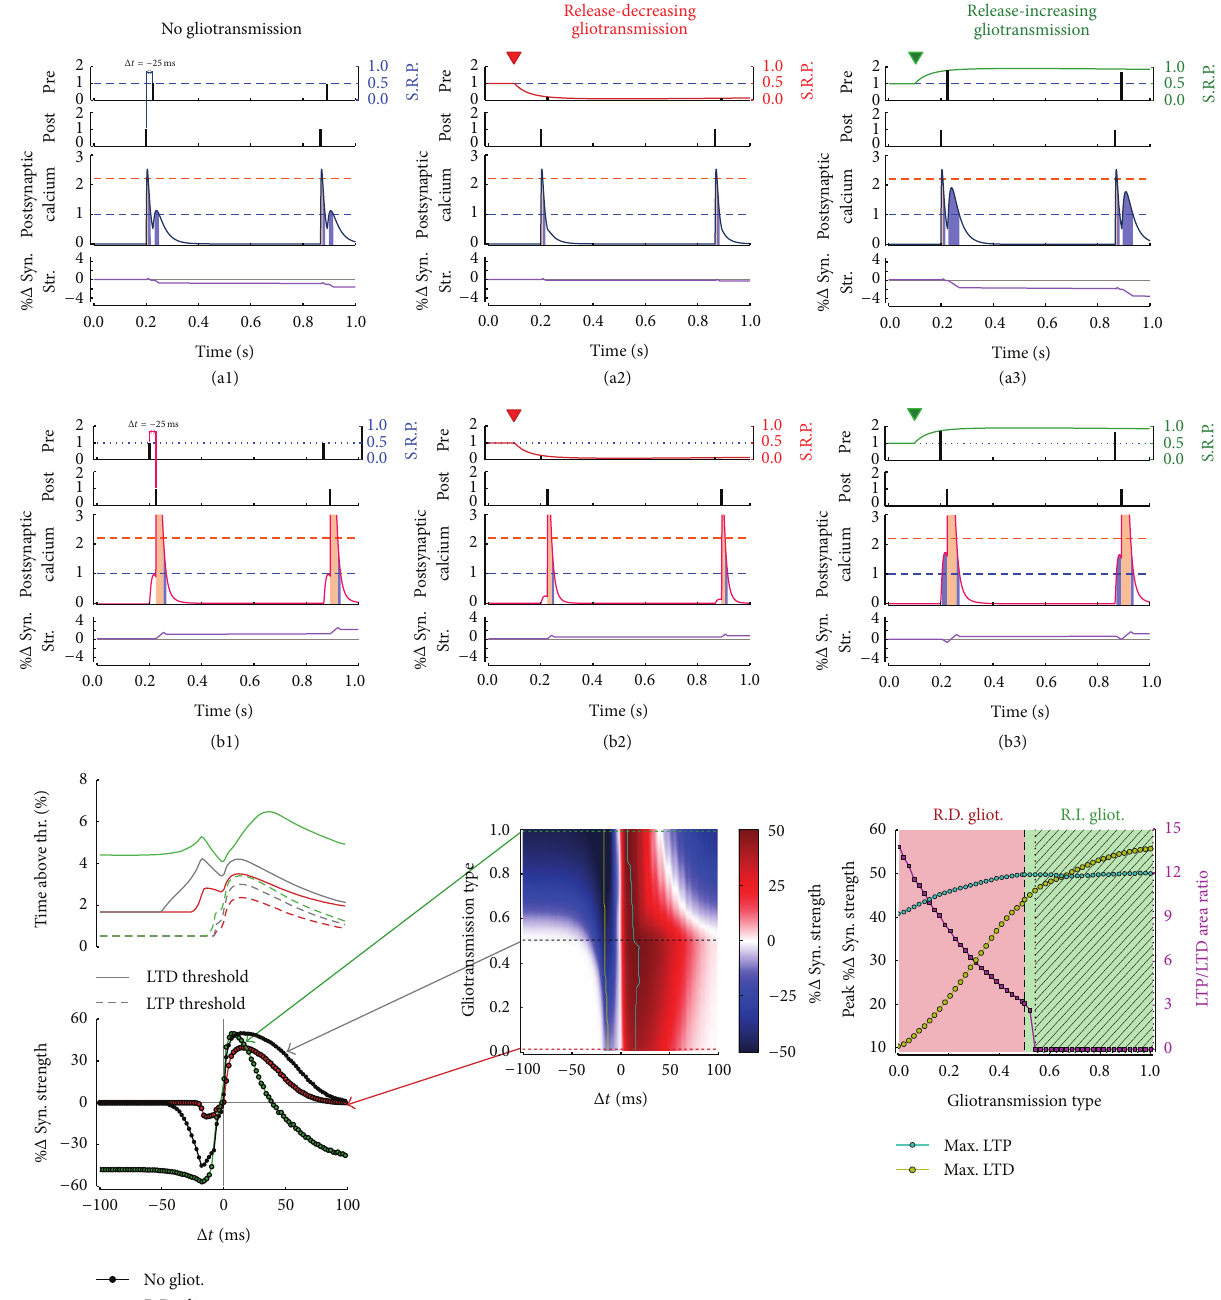
Figure 6: STDP modulation by gliotransmitter regulation of synaptic release. ((a), (b)) Rationale of LTD and LTP without ((a1), (b1)) and with either release-decreasing ((a2), (b2), 𝜉 = 0 ) or release-increasing gliotransmission ((a3), (b3), 𝜉 = 1 ) setting on at the red / green marks . (c) Percentage of time spent by postsynaptic Ca 2+ transients ( left panel ) above depression ( dashed lines ) and potentiation thresholds ( solid lines ) for spike-timing intervals ( Δ𝑡 ) within ± 100ms and resulting STDP curves ( right panel ) in the absence of gliotransmission (no gliot., black curve ) and with maximal release-decreasing (RD, red curve ) or release-increasing gliotransmission (RI, green circles ). (d) In general, strength and direction (i.e., “type”) of gliotransmission may dramatically modulate STDP. For example, synaptic changes are attenuated when synaptic release is decreased by gliotransmission (area below the black dashed line ). Conversely, for sufficiently strong release-increasing gliotransmission (area above the black dotted line ), the LTP window shrinks and LTD may be measured for all Δ𝑡 < 0 , as well as for sufficiently large Δ𝑡 > 0 . (e) A closer inspection of STDP curves indeed reveals that LTD ( yellow curve ) increases for larger synaptic release accounted by gliotransmission, while the ratio between areas underneath the LTP and LTD ( magenta curve ), initially in favor of the former (i.e., for release-decreasing gliotransmission), reduces to zero for large enough release-increasing gliotransmission, when two open LTD windows appear outside a small LTP window center for small Δ𝑡 > 0 ( hatched area ). Synaptic parameters: 𝜏 𝑑 = 0.33 s, 𝜏 𝑓 = 0.33 s, and 𝑈 = 0.5 s. Other parameters as in Table 1 except for 󰜚 𝑒 = 10 −4 , 𝜏 𝑐 = 1 ms, 𝑊 𝑁 = 78.7 , 𝜏 𝑃 = 5 s in ((a), (b)), and 𝜏 𝑃 = 30 s